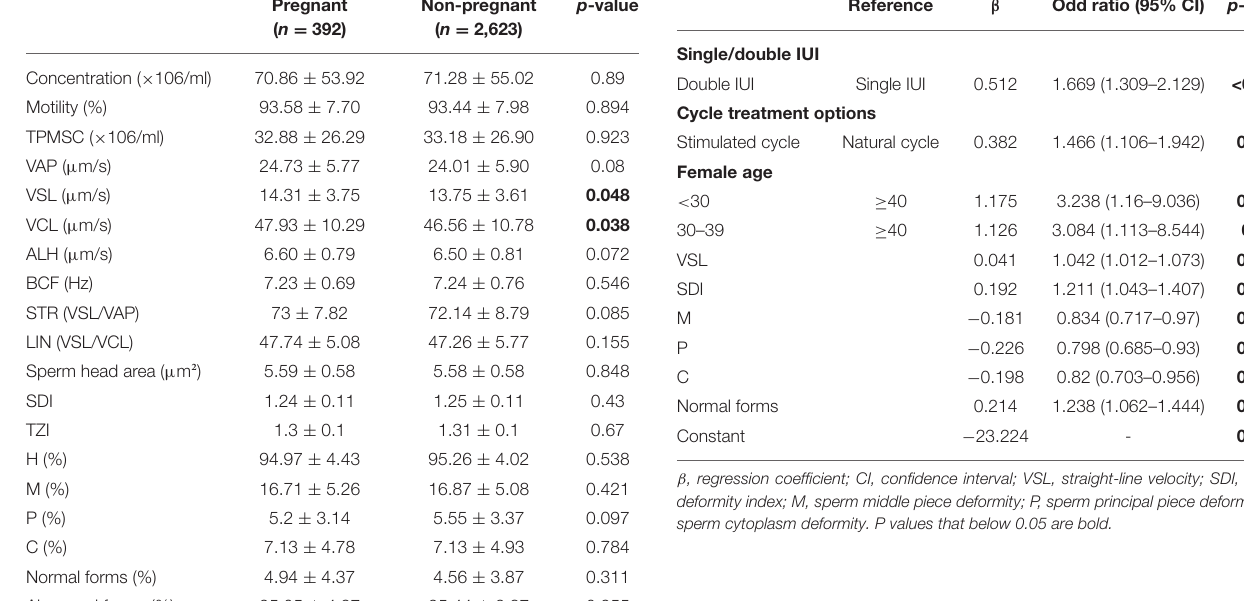
TABLE 3 | Multivariate logistic regression analysis of influencing factors for AIH pregnancy.